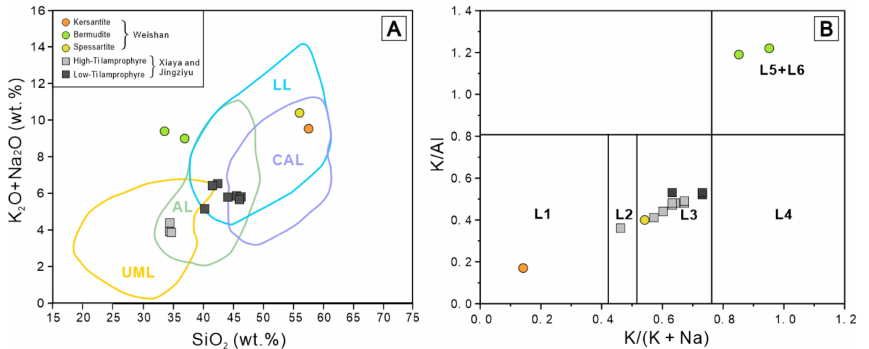
Figure 5. TAS classification diagram of the lamprophyre from the Weishan area and data previously compiled for the Jingziyu and Xiaya area of the Luxi Terrane [35]. Data are given in Table 1.